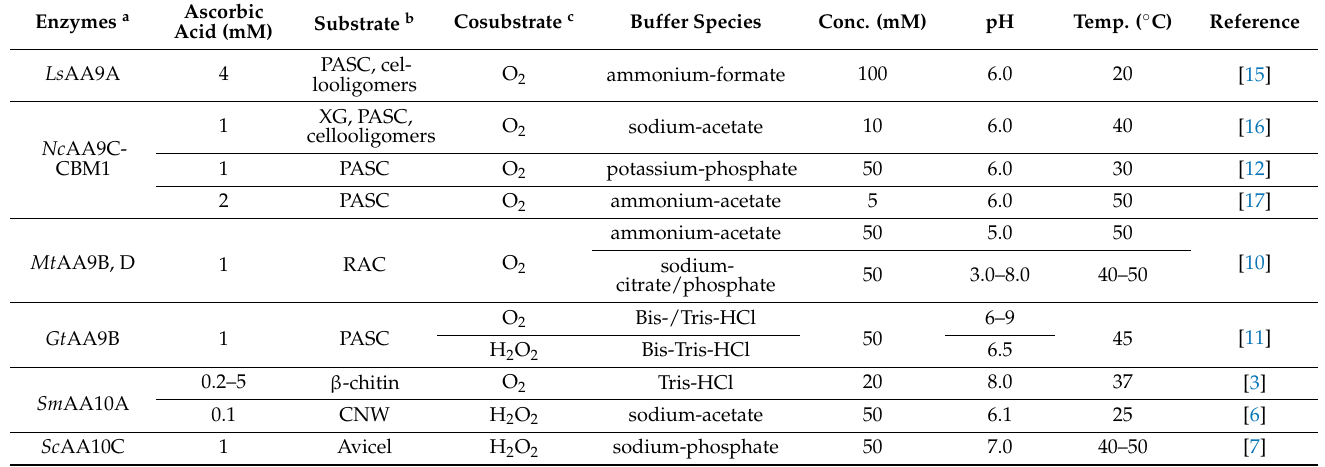
Table 1. Commonly used conditions for lytic polysaccharide monooxygenases (LPMO) in conversion experiments of cellulose and